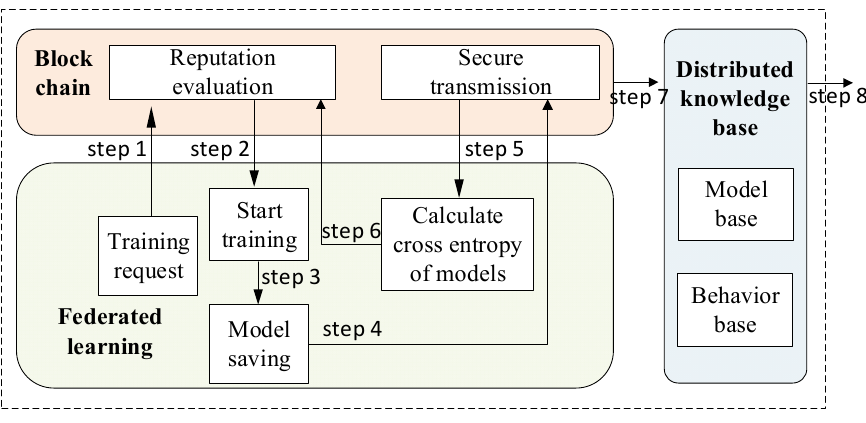
Figure 6. Call framework diagram of module.